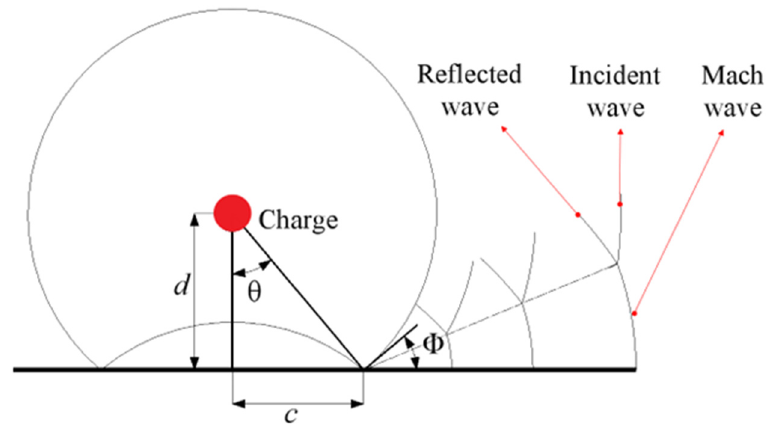
Figure 8. Schematic diagram of shock wave wall reflection.